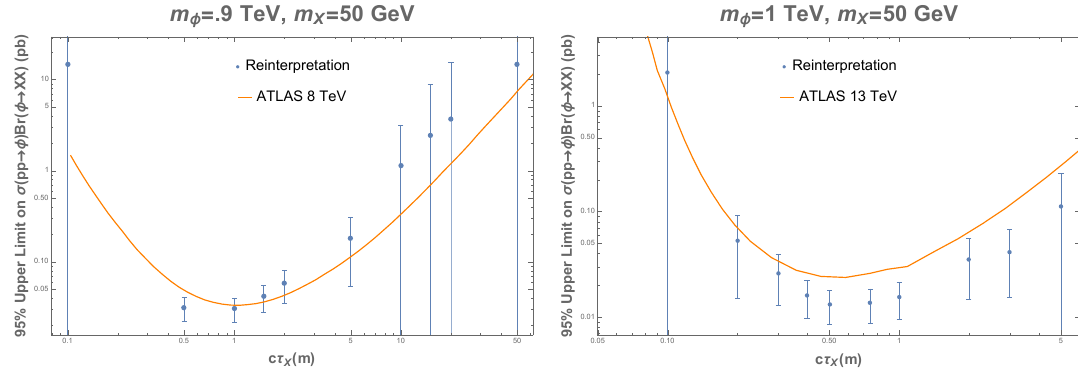
Figure 8 . In both panels the orange line is the result given by the experimental collaboration and the blue dots correspond to the result of our reinterpretation, where the error band are estimated from our montecarlo by taking the variable we are plotting and multiplying it by 2 = N are the number of events passing the cuts. Left: a comparison between the 95% sigma times branching ratio limits placed by the 8 TeV ATLAS analysis [41] and our reinterpretation as described in appendix B.1, for an example mass point m (cid:30) = 0 : 9 TeV, m X = 50 GeV. Right: a comparison between the 95% cross section times branching ratio limits placed by the 13 TeV ATLAS analysis [32] and our reinterpretation as described in appendix B.1, for an example mass point m (cid:30) = 1 TeV, m X = 50